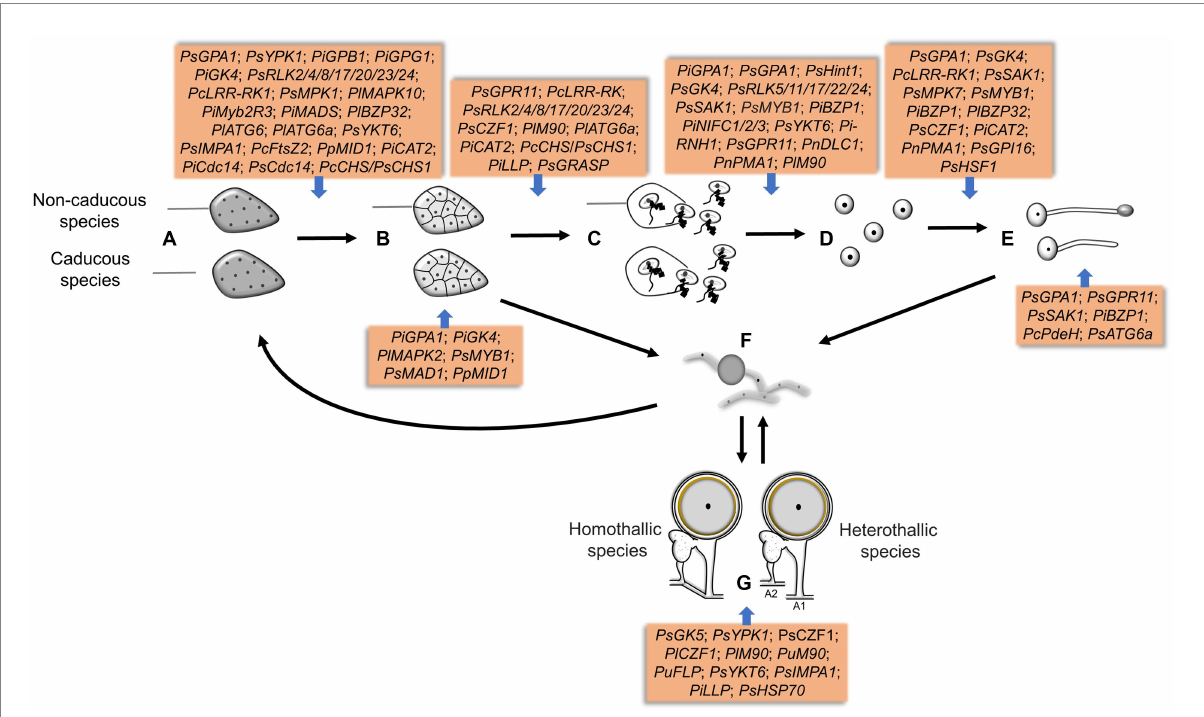
FIGURE 4 The genes involved in different sporulation and germination stages in Phytophthora and Peronophythora . A–G represent sporangia, sporangia cleavage, zoospores release, cysts, cysts germination, mycelia chlamydospores and oospores,